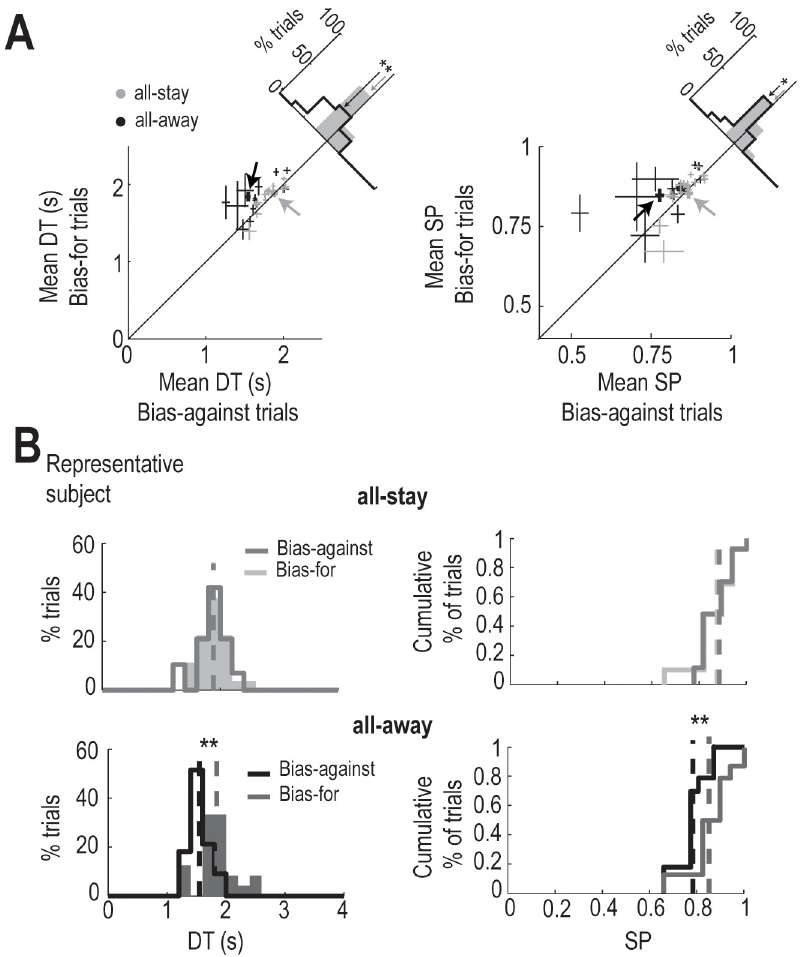
Fig 3. Behavior of subjects during bias-against and bias-for trials. (A) Left panel , DTs observed during bias-against and bias-for trials in all-stay (gray) and all-away (black) conditions. Inset panel shows a histogram with the difference in DTs between the two trial types within each condition. The difference in DTs between bias-against and bias-for trials is significant in the all-away condition but not in the all-stay condition (n = 15; paired-samples t -test, �� p < 0.01; p = 0.001, t = 3.96). A Bayes Factor of 16.929 ( > 3) in the all-away condition and of 0.249 ( < 1/3) in the all-stay condition confirm the results. Right panel , SPs at decision time for bias-against and bias-for trials. Inset panel shows a histogram with the difference between SPs for the two trial types within each condition. The difference is significant only in the all-away condition (n = 15; paired-samples t -test, � p < 0.05; p = 0.01, t = 2.78). A Bayes Factor of 4.063 ( > 3) in the all-away condition and of 0.277 ( < 1/3) in the all-stay condition support the result. Error bars indicate SEM. (B) DTs and SPs for the same subject as in Fig 2B, whose mean DT and SP values are indicated with arrows in (A). The subject exhibits the same behavioral effect as was observed for the group: the DT and SP only differed significantly between bias-against and bias-for trials in the all-away condition (n bias-against = 33, n bias-for = 24; Kolmogorov–Smirnov test, �� p < 0.001; DTs, p = 0.00002, D = 0.62; SPs, p = 0.0001, D =